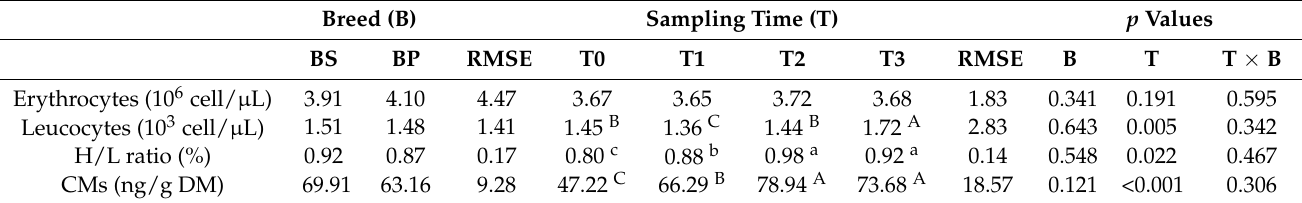
Table 2. Effect of regrouping on hematological parameters and droppings corticosterone metabolites (CMs) concentrations in Bianca di Saluzzo (BS) and Bionda Piemontese (BP) laying hens according breed and sampling time (n =